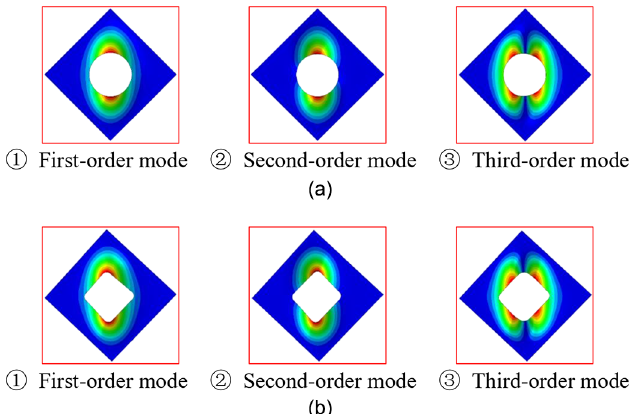
Fig. 4. Buckling modes of square plates with different holes. (a) Square plate with circular hole. (b) Square plate with fi llet square hole.